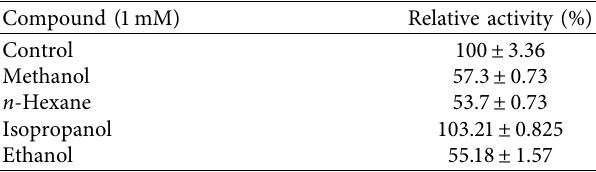
Table 2: Stability of K . flava Y4 lipase in organic solvents.